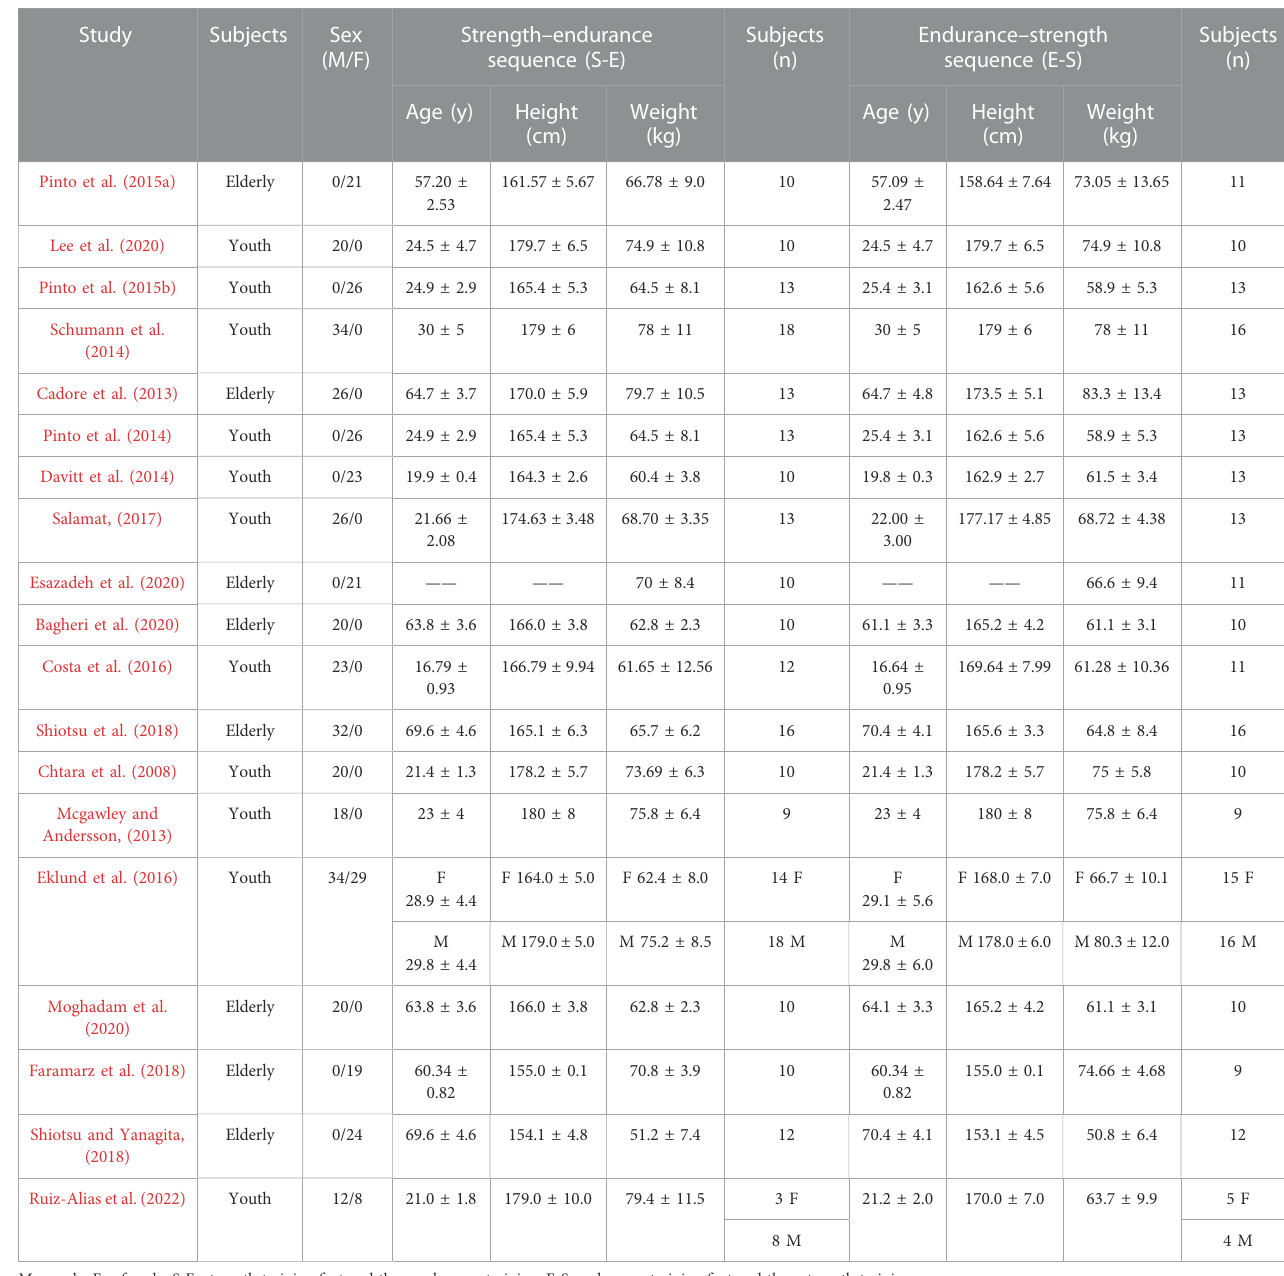
TABLE 1 Summary of included